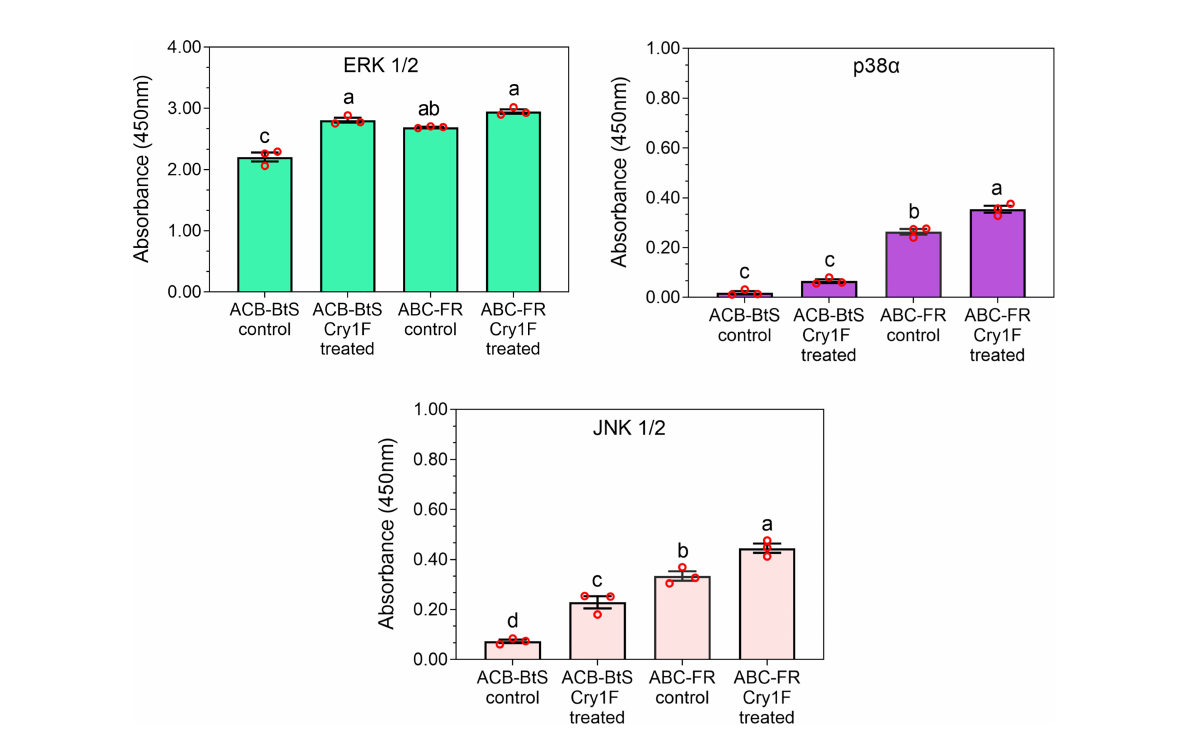
FIGURE 7 Activity of selected mitogen-activated protein kinases (MAPKs) in hemocytes from ACB-BtS and ACB-FR larvae in response to Cry1F treatment. MAPK activity (mean and corresponding standard errors from three biological replicates) in hemocyte lysates after 48 h of treatment with Cry1F toxin (1,075 m g/g; toxin/diet). Antibody cocktails detected MAPK family kinase enzymes ERK 1/2, p38 a , and JNK 1/2. Different letters on vertical bars represent statistically signi fi cant differences between treatments for the speci fi c gene tested (One Way ANOVA and post hoc LSD Tukey test; P <